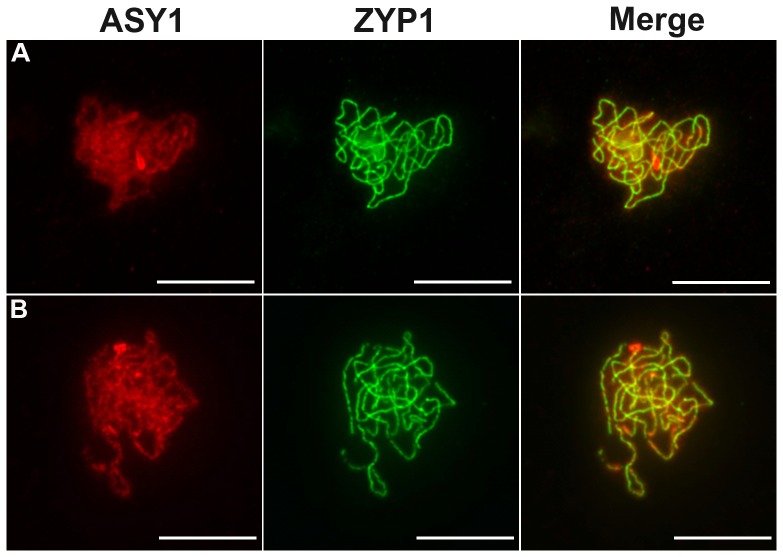
Coimmunolocalization of ASY1 and ZYP1.ASY1 (red), ZYP1 (green) are shown as well as the overlay of both signals (merge) at pachytene in (A) wild type and in (B) Atmcm8 mutant. In both wild type and mutant the polymerization of the synaptonemal complex, revealed by ZYP1, is completed at pachytene. The ASY1 signal is largely depleted from the chromosomes as the synaptonemal complex forms. Bar, 10 µm.